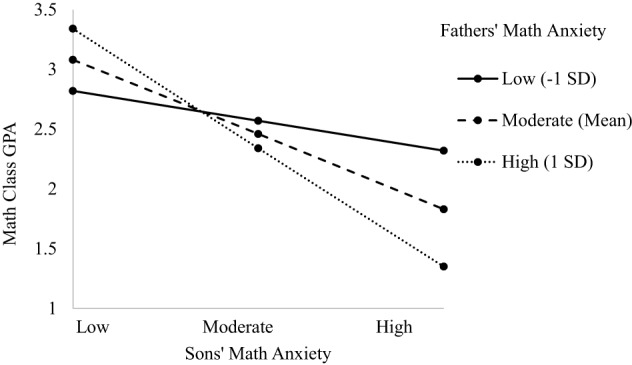
Three-way interaction predicting math GPA from Father's and Son's math anxiety.